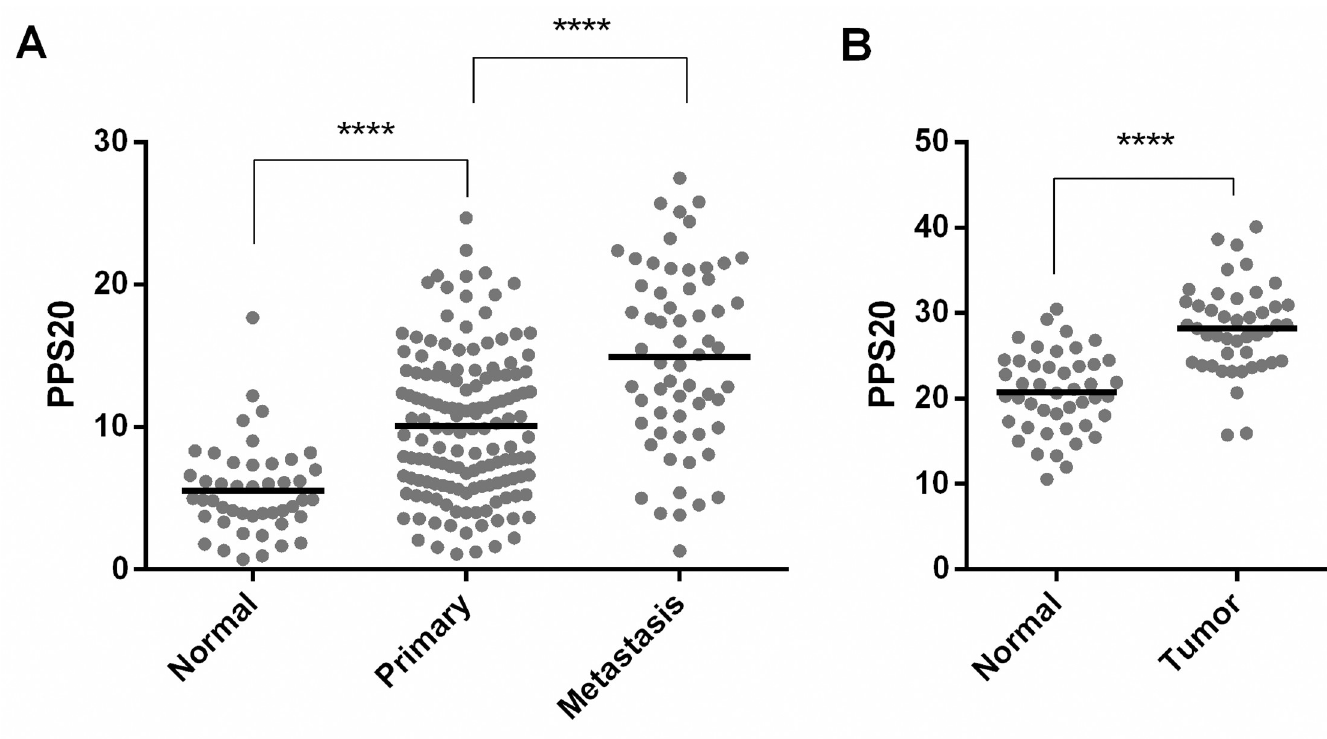
Fig 4. PPS20 is significantly different between normal, tumor and metastatic tissues. PPS20 in normal (n = 46), primary (n = 145) and metastasic tissues (n = 61) of GSE71729 (A). PPS20 in 45 paired tumor and normal tissues in GSE28735 (B). Horizontal lines indicate mean. Statistical comparisons were performed with unpaired and paired ttest in A and B, respectivelly. ���� p <